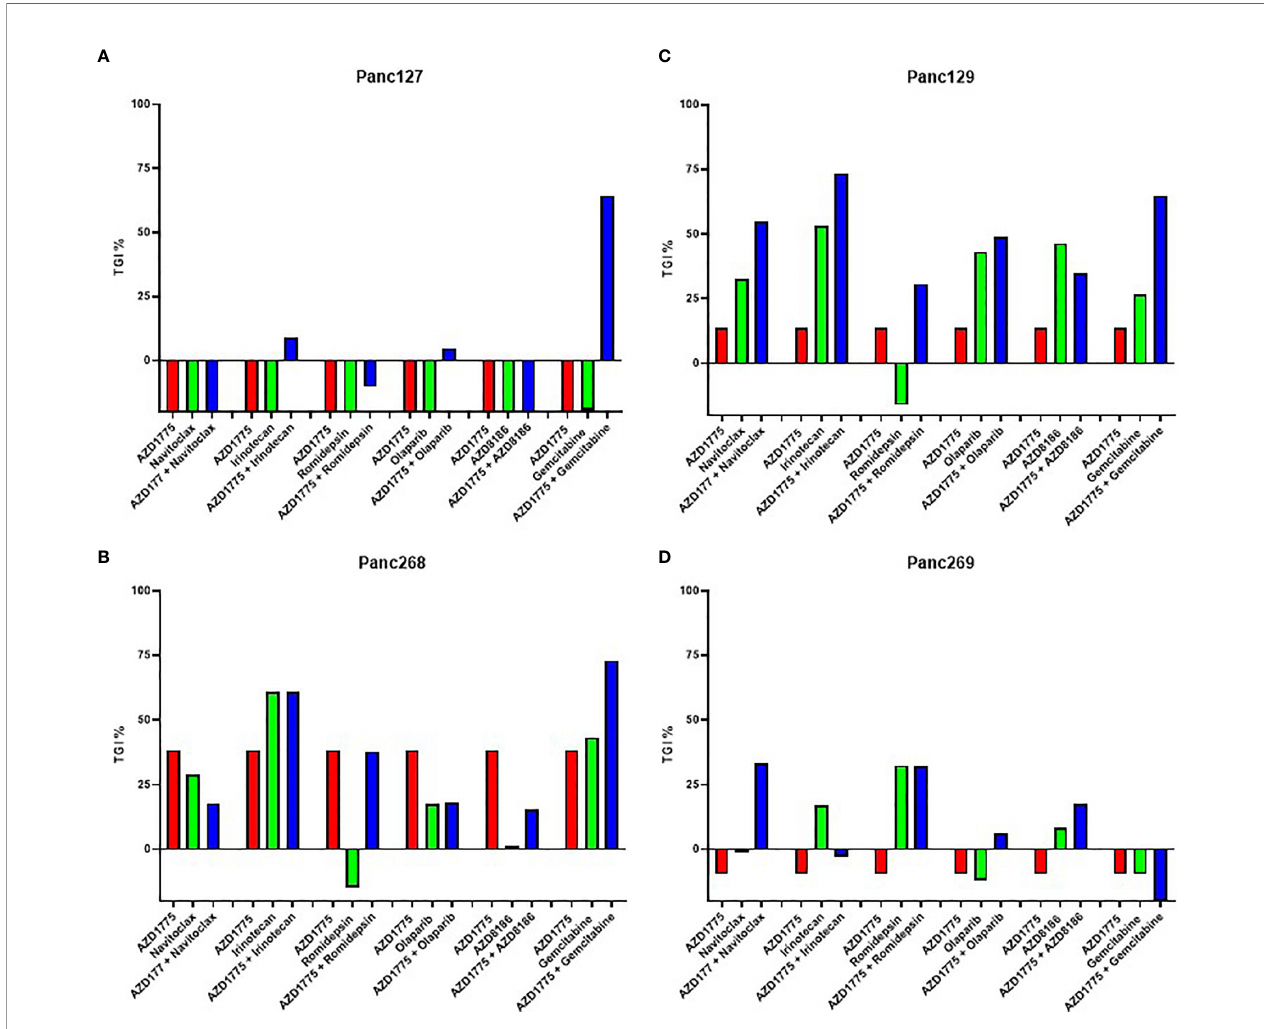
FIGURE 1 | Effect of AZD1775 alone or in combination with chemotherapy or targeted agents in pancreatic ductal adenocarcinoma (PDAC) PDX models. Percent tumor growth inhibition (TGI) values were calculated for each model ( n = 3 mice/group). AZD1775, 50 mg/kg (PO, QD); navitoclax, 100 mg/kg (PO, QWx3); irinotecan, 15 mg/kg (IP, QW); romidepsin, 1.34 mg/kg (IP, QW); olaparib, 50 mg/kg (PO, QD); AZD8186, 25 mg/kg (IP, QD); gemcitabine, 40 mg/kg (IP, QW). (A) Panc127, (B) Panc268 (p53 MT , KRAS MT ), (C) Panc129 (p53 MT , KRAS MT ), (D) Panc269 (p53 MT , KRAS MT , CDKN2A MT